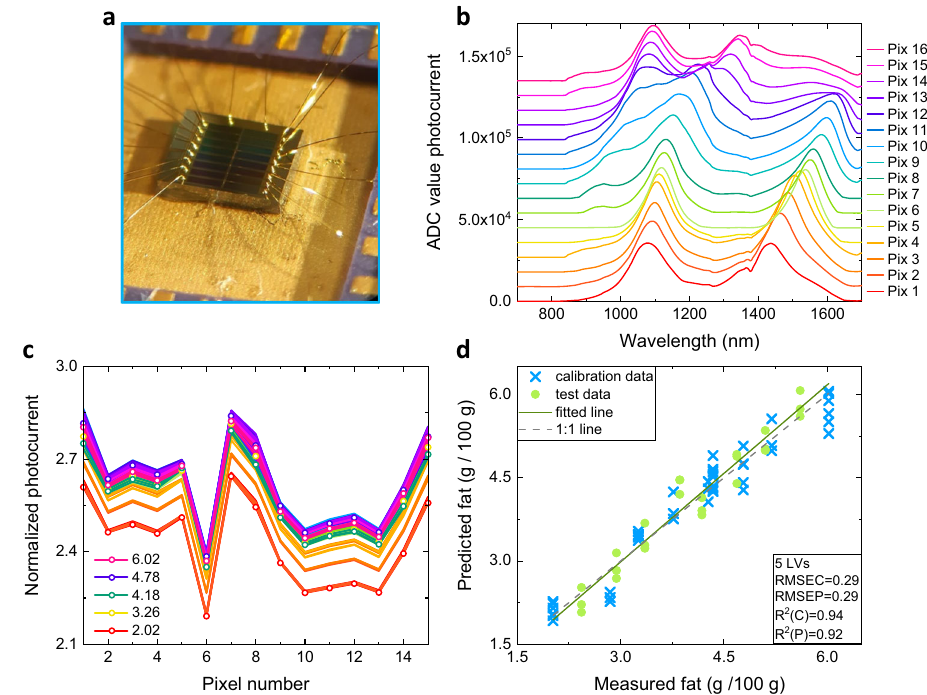
Fig. 4 Spectral sensing of milk samples. a Wire-bonded array for single-shot readout. b Response curves of wire-bonded pixel array for sensing. ADC photocurrent values were measured with the developed ampli fi er board as a function of wavelength of illumination (linewidth ~5.5 nm, power ~1.95 μ W). An offset with increasing steps of 9000 ADC between the response curves of different pixels is added for clarity. c Scaled absorbance values of selected raw milk samples measured for the 15 RCE pixels. d The fat content predicted via PLS regression using normalized photocurrent values from the RCE detector compared to the expected fat content. The number of latent variables (LVs), the root mean square error of calibration (RMSEC) and prediction (RMSEP), and the coef fi cient of determination for both the calibration R 2 (C) and prediction R 2 (P) are